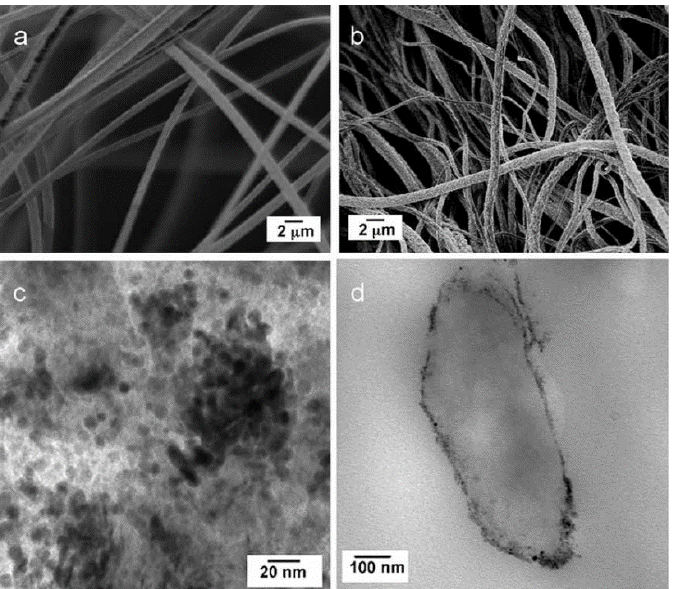
Figure 12. SEM images of ( a ) electrospun PSEI nanofibers and ( b ) TiO 2 LBL-NF. TEM image of ( c ) TiO 2 NPs and ( d ) the cross-section of TiO 2 LBL-NF. (Reprinted from the work of Lee et al. [43]. Copyright 2010, with permission from John Wiley and Sons).